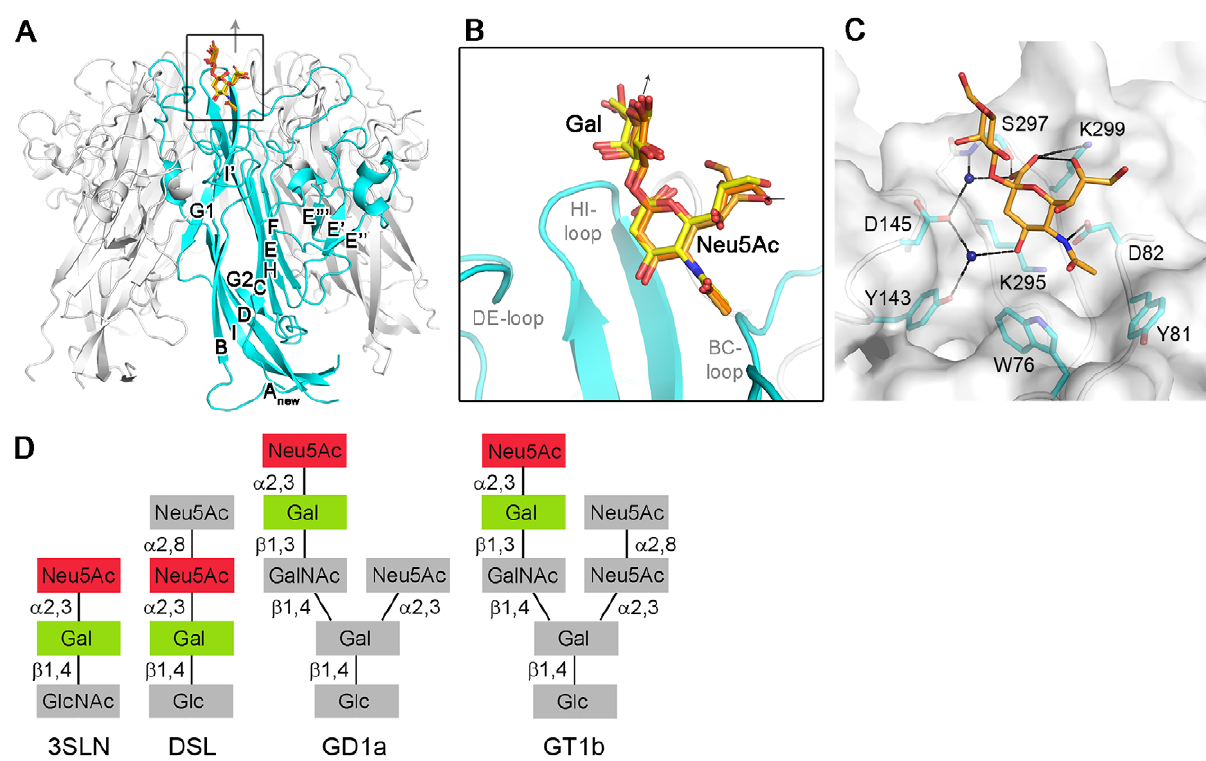
Figure 1. Structure of MCPyV VP1 in complex with sialylated oligosaccharides. (A, B) The protein is shown in cartoon representation, with one VP1 monomer highlighted in cyan and the other monomers depicted in gray. The oligosaccharides are drawn as stick models. Nitrogen and oxygen atoms are colored blue and red, respectively, and carbon atoms are colored orange for 3SLN, light orange for DSL and yellow for GD1a. (C) Interactions between MCPyV VP1 and the Neu5Ac- a 2,3-Gal motif of DSL. The protein surface is colored grey, the protein backbone is depicted in cartoon representation and colored grey, and side chains interacting with the ligand are shown in stick representation and colored by element. Hydrogen bonds and salt bridges are shown as dashed lines, and water molecules mediating hydrogen bonds are indicated as dark blue spheres. (D) Schematic representation of the oligosaccharide structures used in this study. The binding epitope is highlighted in color.